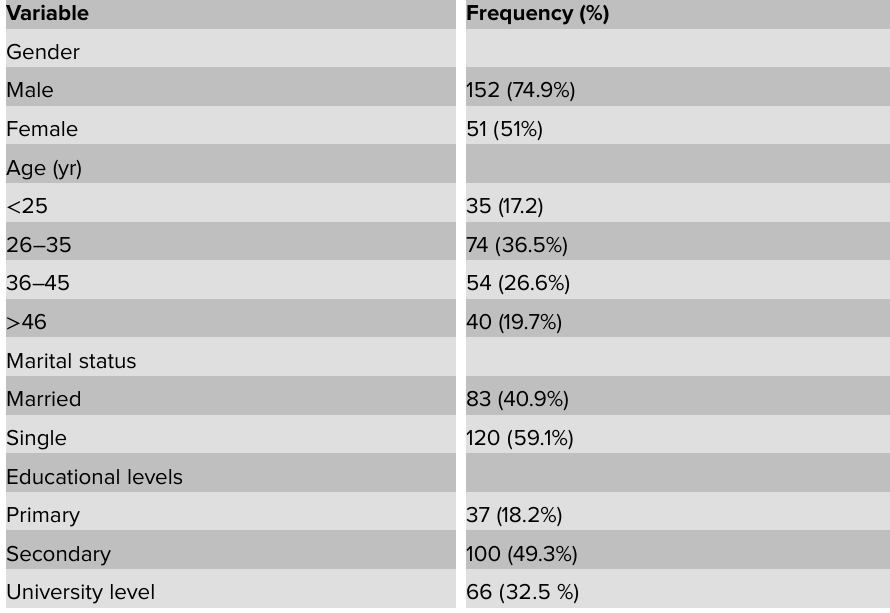
Table 1: Demographic variables of stakeholders ( N =